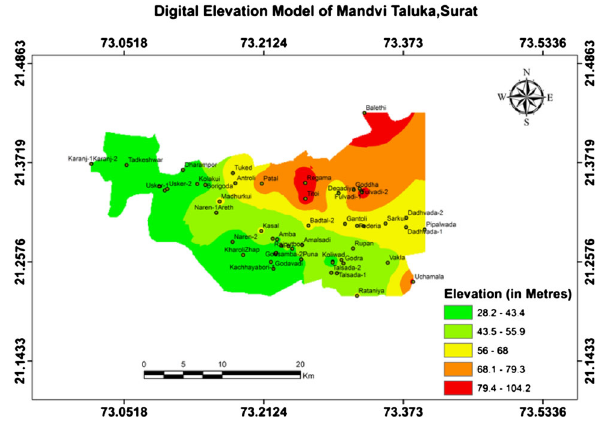
Fig. 3 Digital elevation model for Mandvi Taluka, Surat